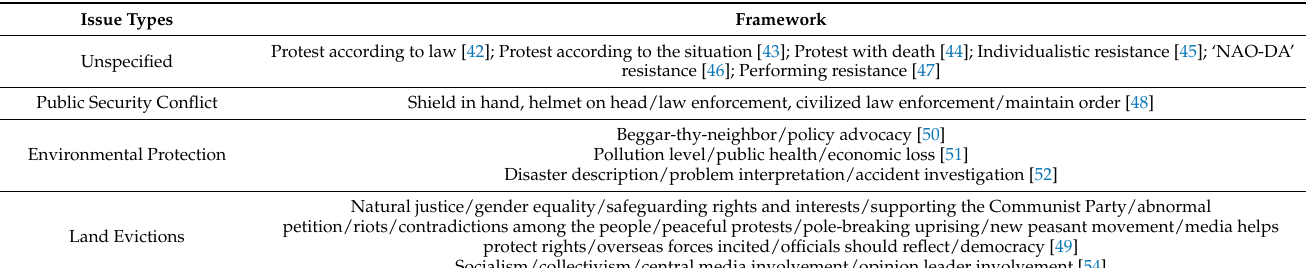
Table 1. Framework names and types in existing